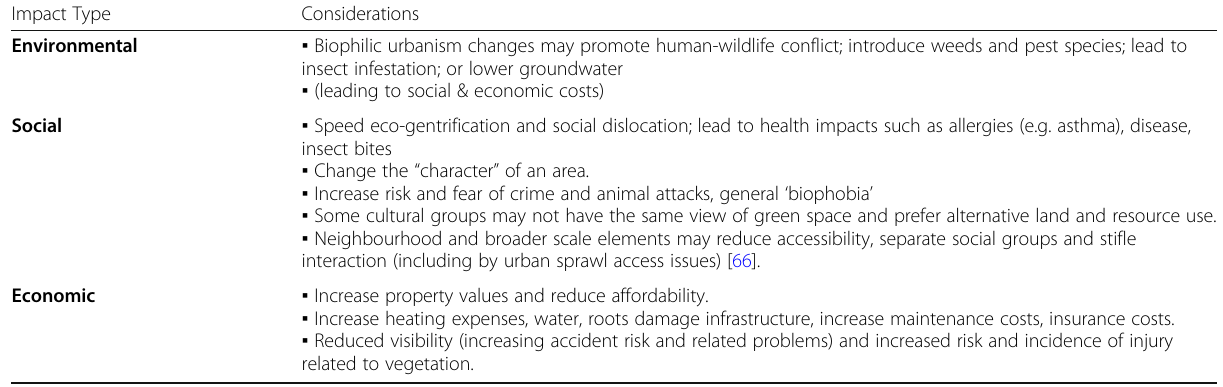
Table 3 Potential community (private and external) costs of biophilic urbanism initiatives Impact